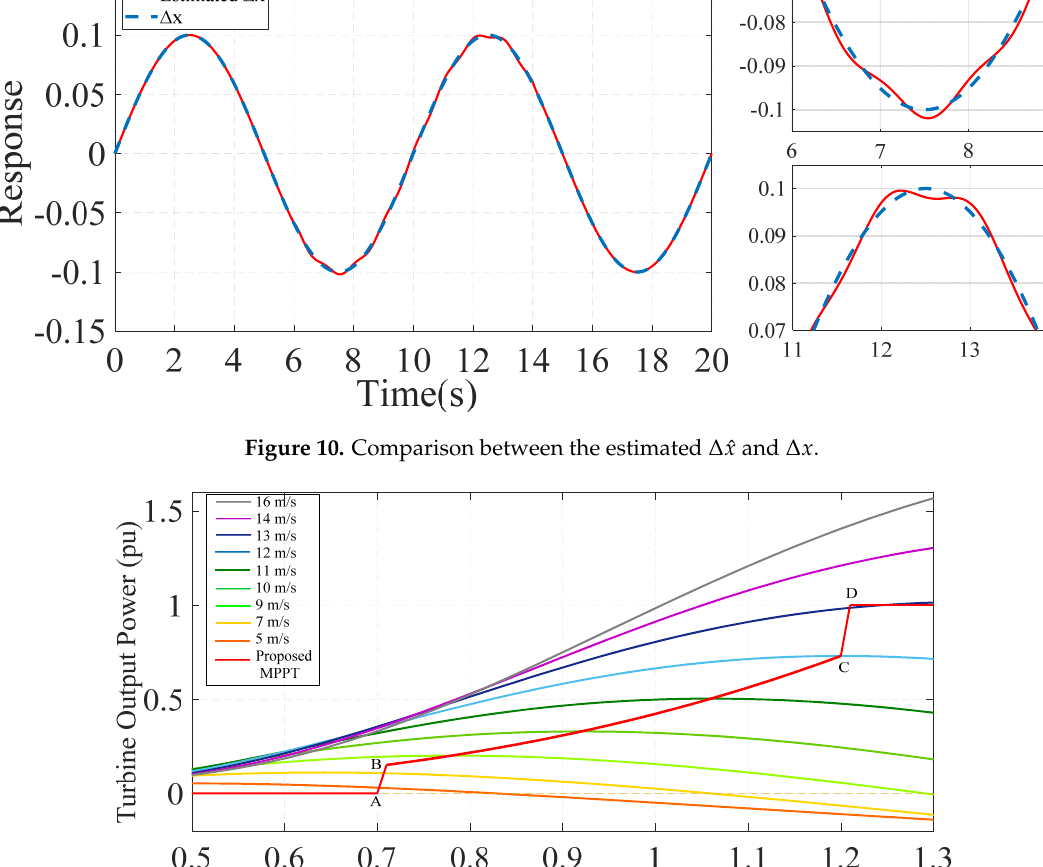
Figure 9. FLC output error.